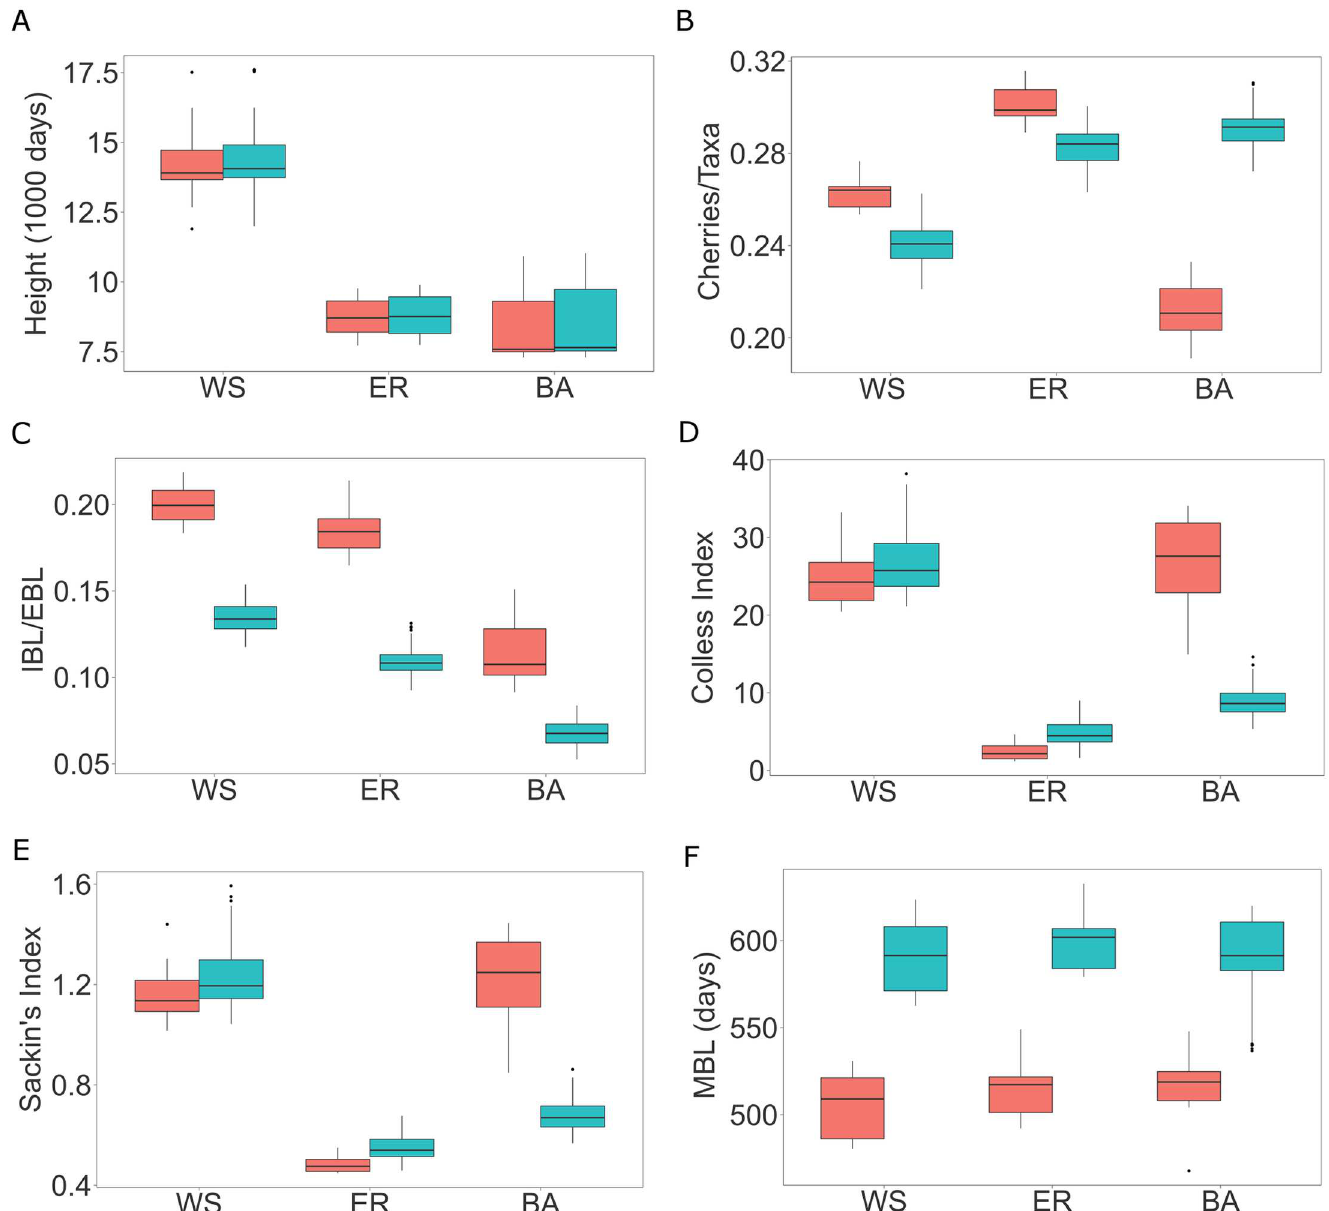
Fig 3. Box plots of tree statistics on transmission trees ( red ) and reconstructed virus genealogies ( light blue ). Tree height (A), number of cherries per taxa (B), mean internal/external branch lengths ratio (C), Colless Index (D), Sackin’s Index (E), mean branch length (F). The boxes correspond to the first and third quartiles. The upper/lowerwhisker extends from the third/first quartileto the highest/lowest value which is within 1.5 IQR from the box, where IQR is the inter-quartile range.